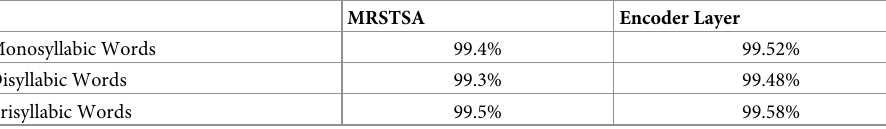
Table 1. SVM 5-fold cross validation training